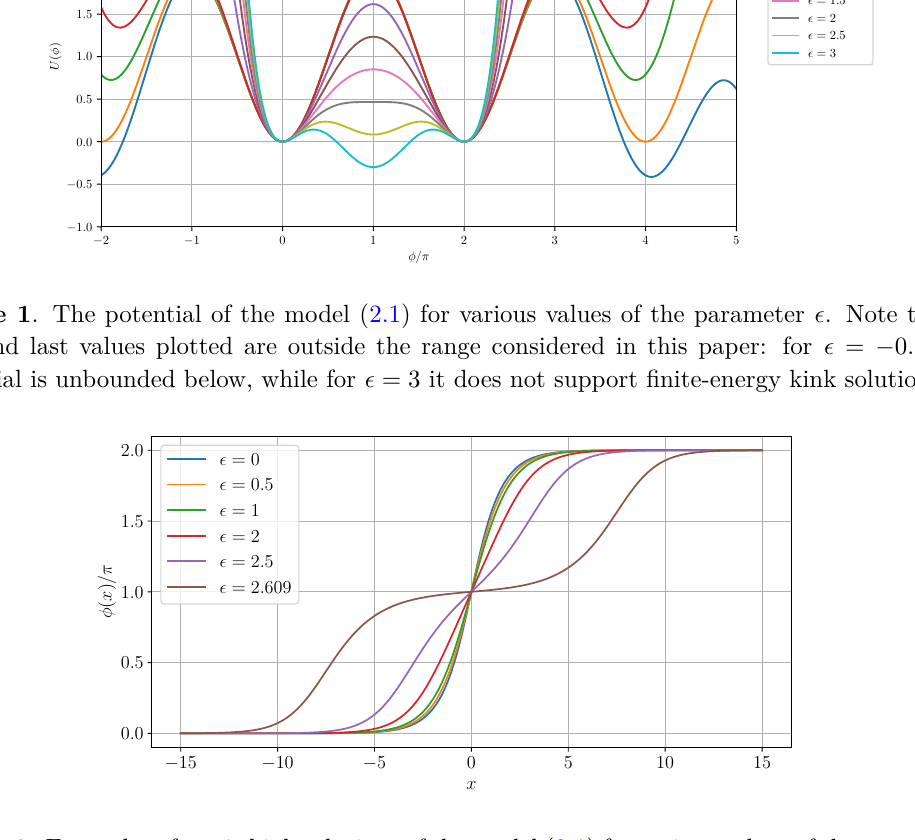
Figure 2 . Examples of static kink solutions of the model (2.1) for various values of the parameter (cid:15)